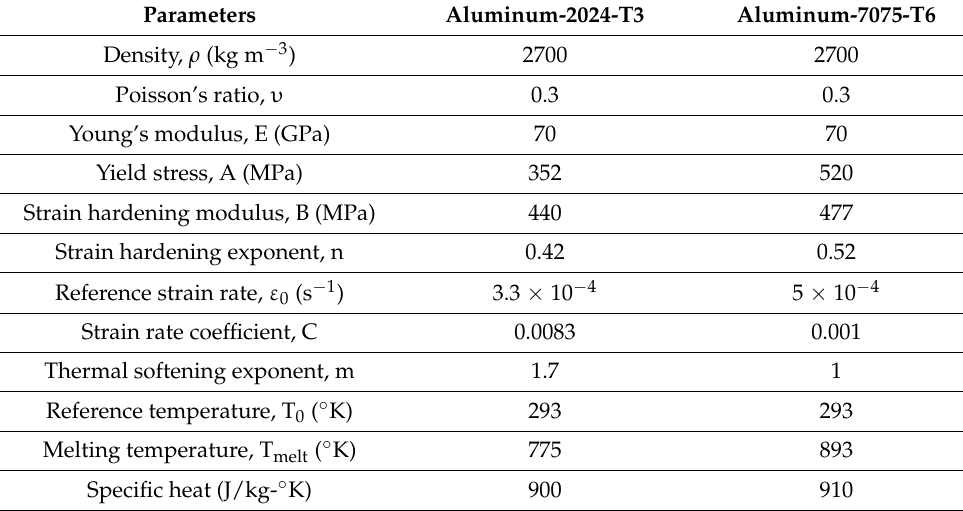
Table 1. Johnson–Cook material parameters of Aluminum alloys [35].